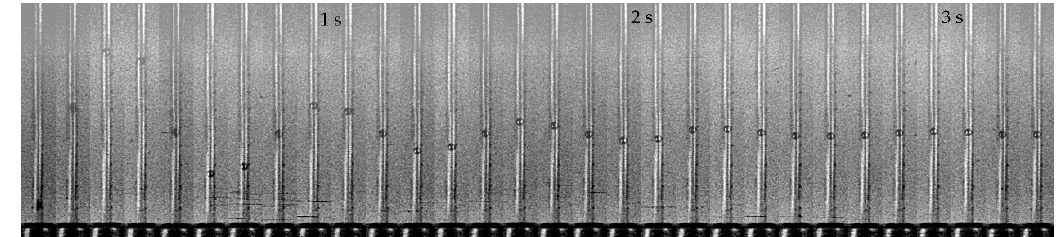
Figure 10. Rotameter no. 7. Selected images of a step response captured by a camera.